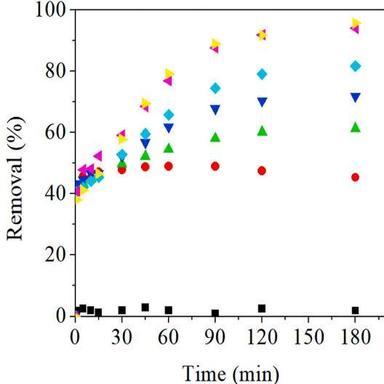
Results of the experiments studying the effect of doseH2O2 on the removal of DR80 from solution by the EG-nZVI. doseH2O2 = ■ 0 mmol L− 1 ; 0.5 mmol L− 1 ; 1.25 mmol L− 1 ; 1.5 mmol L− 1 ; 2 mmol L− 1 ; 3.5 mmol L− 1 ; 5 mmol L− 1 . Other reaction conditions: doseFe = 10 mg L− 1 and pH0 = 5.5.